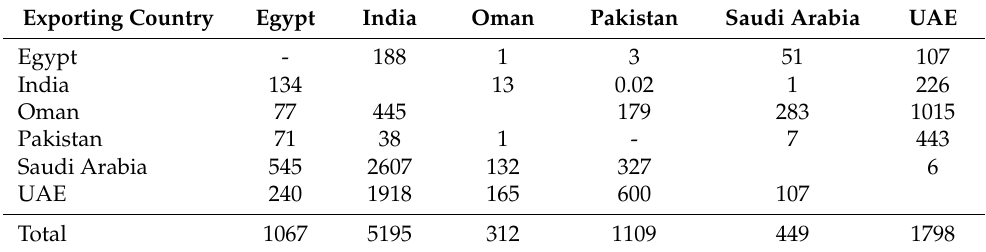
Table 1. Matrix of food bilateral trade in million dollars in 2020 between the selected countries. Exporting